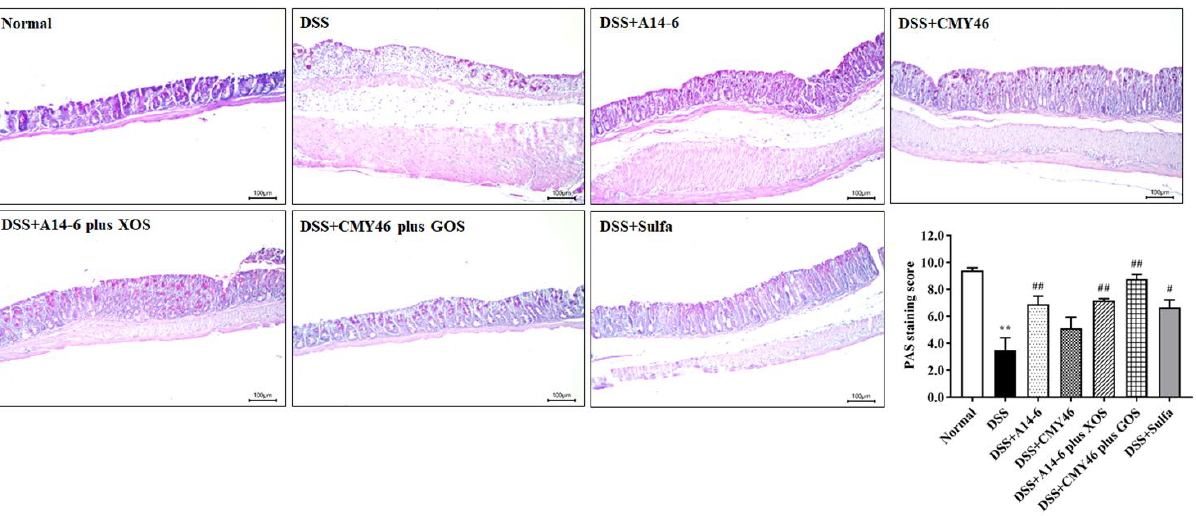
Figure 4. The effect of probiotics and synbiotics from Miang on mucus-secreting goblet cells. PAS staining of mucosal glycoproteins in goblet cells in the apical epithelial cells was observed with intense magenta color in the apical epithelial cells. PAS staining score was analyzed using light mi- croscopy (×200 magnification) from at least five fields. Data are expressed as mean ± SEM ( n = 7), ** p < 0.01 vs. normal group. # p < 0.05; ## p < 0.01 vs. DSS group. Next, we investigated the involvement of probiotics and synbiotics on mucosal bar- rier integrity in the colon. The expression of intestinal epithelial cell tight junction (ZO-1, occluding, and claudin-1) and cell surface mucin (MUC-1) were also determined in the colonic tissue by qRT-PCR. As shown in Figure 5a–d, our results indicated that ZO-1 was significantly downregulated but did not involve the other tight junctions challenged by duced intestinal barrier dysfunction.